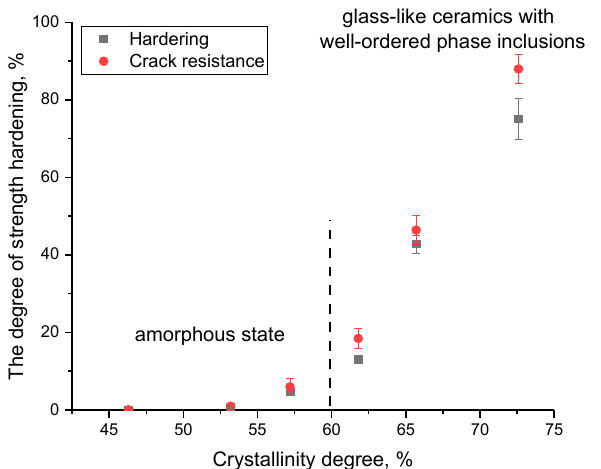
Figure 10. Dependence of the change in strength characteristics on the structural ordering degree. As is evident from the data presented, the strengthening of ceramics is observed with an increase in the structural ordering degree above 60%, which means that the proportion of formed grains in the structure of ceramics prevails over the amorphous component. It is also worthwhile to note that the most pronounced change in strength characteristics is manifested in a crack resistance growth, which increases due to the formation of a grain structure that prevents the propagation of cracks under external in fl uence. At the same time, as is known, the formed PbWO 4 grains are inorganic compounds of lead and tung- sten with a density of more than 8.2 g/cm 2 , which makes them one of the promising ma- terials for the shielding and absorption of gamma radiation. In turn, the e ff ect of strength- ening ceramics can also be due to the e ff ect of a change in the density of ceramics when grains dominate in the PbWO 4 structure. Figure 11a represents the results of a compara- tive analysis of changes in the density of the obtained glass-like ceramics. Density estima- tion was carried out by two methods: X-ray phase analysis based on changes in structural parameters and the standard method of Archimedes. For comparison, the results of a the-